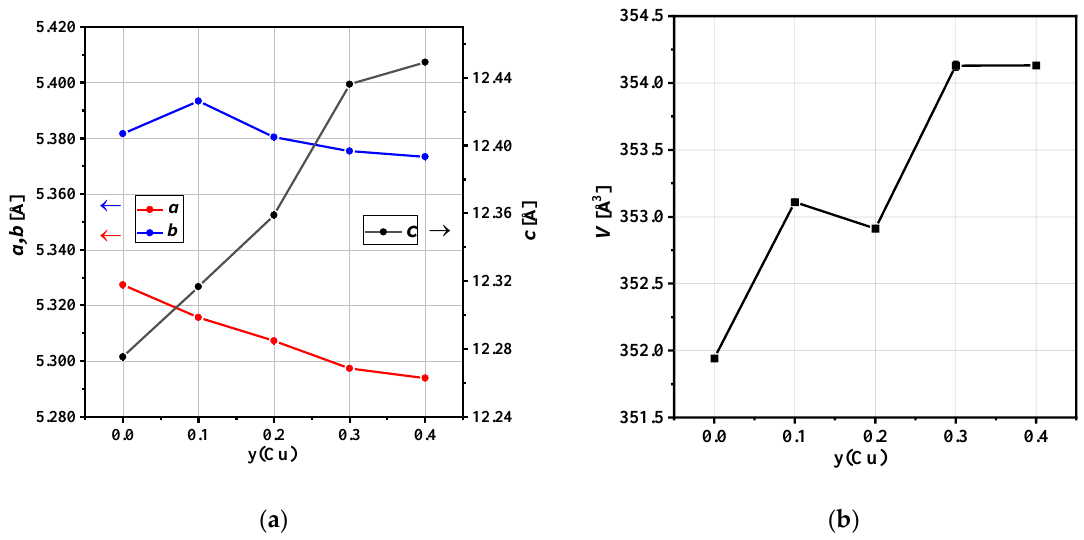
Figure 2. Concentration dependencies of the lattice parameters ( a ) and the unit cell volume ( b ) of the as-synthesized NCNCO00–NCNCO04 samples. (Error bars are not visible on the graph as they are of the size of the symbols for the data points).